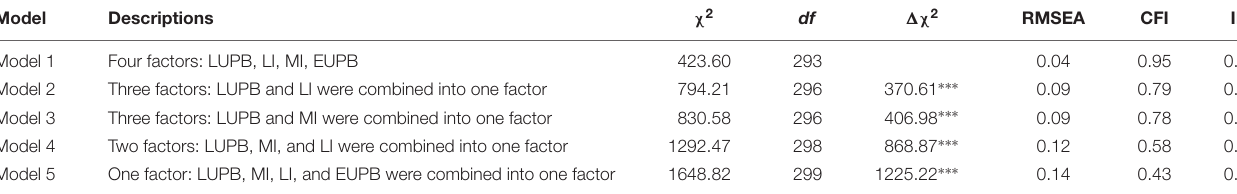
TABLE 1 | Comparison of Measurement Models.